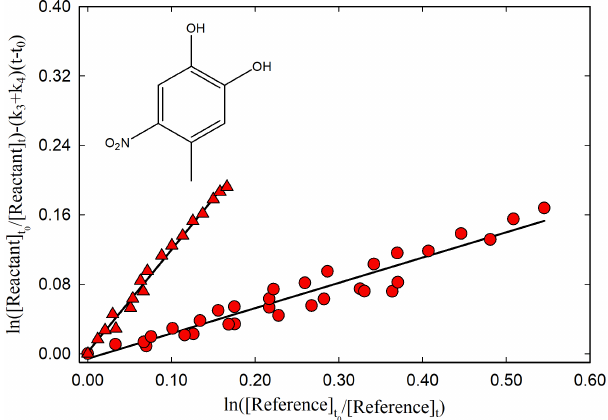
Figure 4. Kinetic plot according to Eq. (1) for the reaction of 4- methyl-5-nitrocatechol with OH radicals relative to dimethyl ether (red circle), using photolysis of CH 3 ONO / NO mixture at 365nm as OH-radical source, and relative to methanol (red triangle), us- ing photolysis of H 2 O 2 at 254nm as OH-radical source, with ( k 3 + k 4 ) = (1.02 ± 0.30) × 10 − 4 s − 1